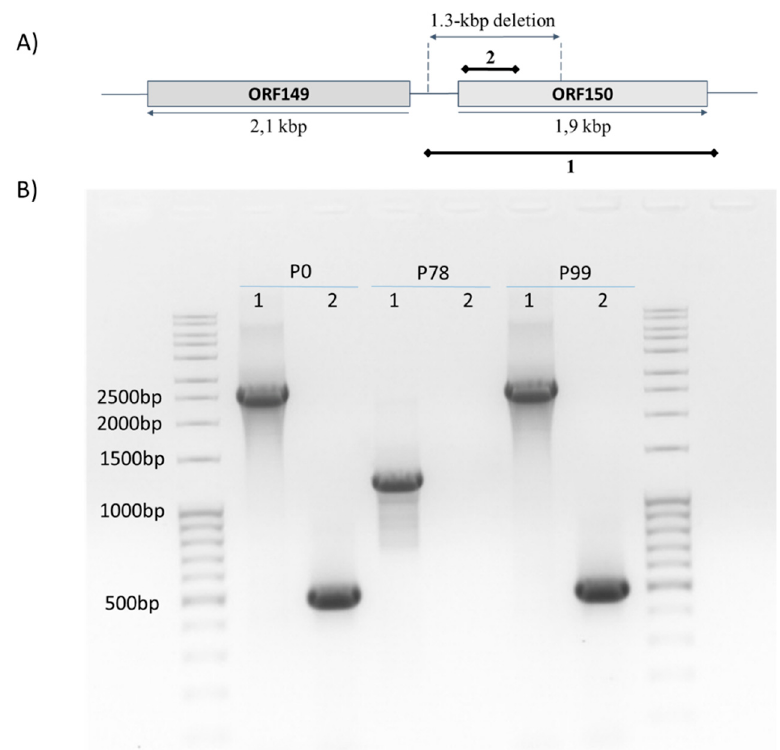
Figure 3. PCR results using the primer set covering the whole ORF150 (1) and the primer set designed inside the deletion (2). ( A ) Schematic representation of the assay design. The expected amplicon sizes according to P0 are 2593 bp, and 500 bp using the two primer sets, respectively. ( B ) The two external lanes were loaded with a 100-bp molecular weight marker, and the corresponding sizes are indicated on the left. 1 and 2 refer to the primer pairs ORF150_-363_F / ORF150_+343_F and ORF150_11_F / ORF150_510_R, respectively (see Table 1).